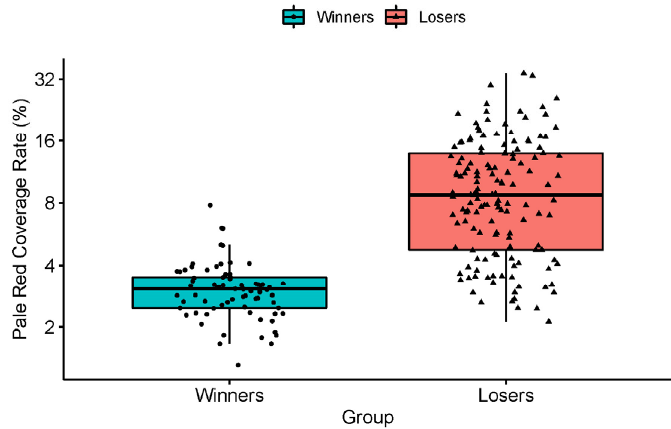
Figure 6. Pale red coverage rate values distribution. Therefore, a high pale red coverage rate ( PRCR ) value corresponded to Kohaku of lower quality.